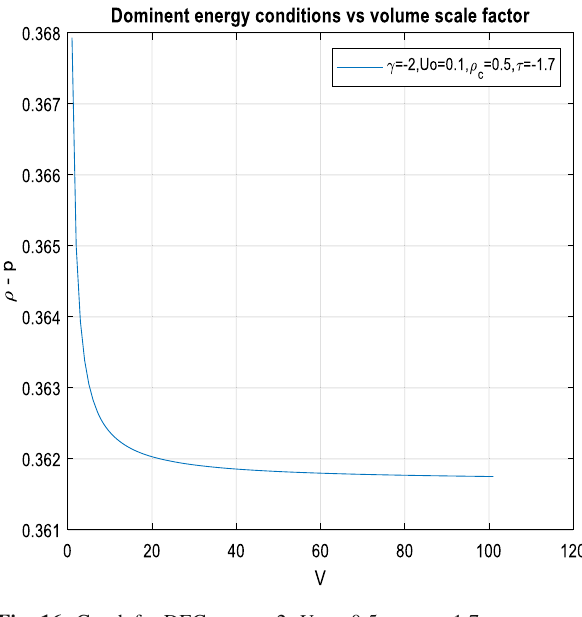
Fig. 16 Graph for DEC; γ = − 2 ; U 0 = 0 . 5 ; τ = − 1 . 7